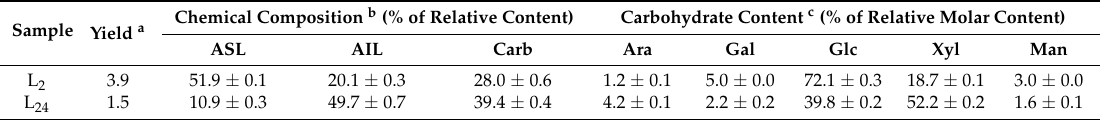
Table 1. Yield, chemical composition, and carbohydrate content of lignin-carbohydrate complex